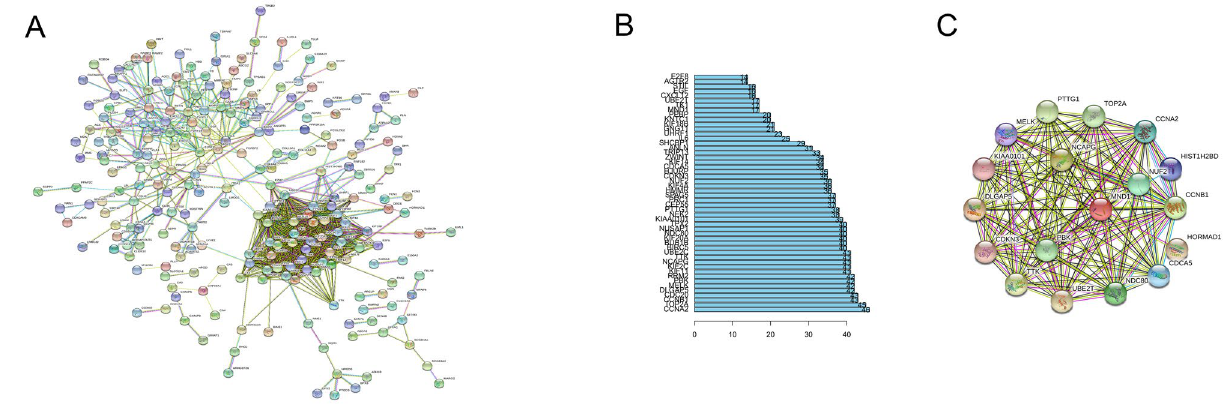
Figure 1. PPI networks of DEGs. ( A ) PPI network of DEGs constructed using STRING. ( B ) Top 50 hub genes. ( C ) MND1-connected Identification of DEGs.